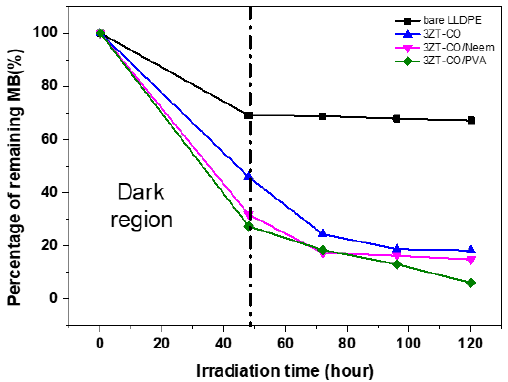
Figure 10. The photocatalytic activity of LLDPE and its composite films on the discoloration of MB under visible light irradiation as a function of degradation time after 48 h.